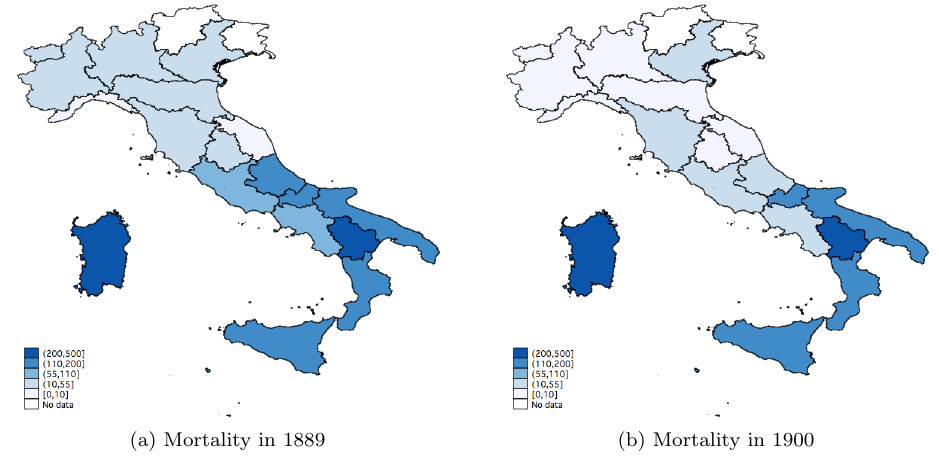
Figure 1: Malaria mortality in 1889 and